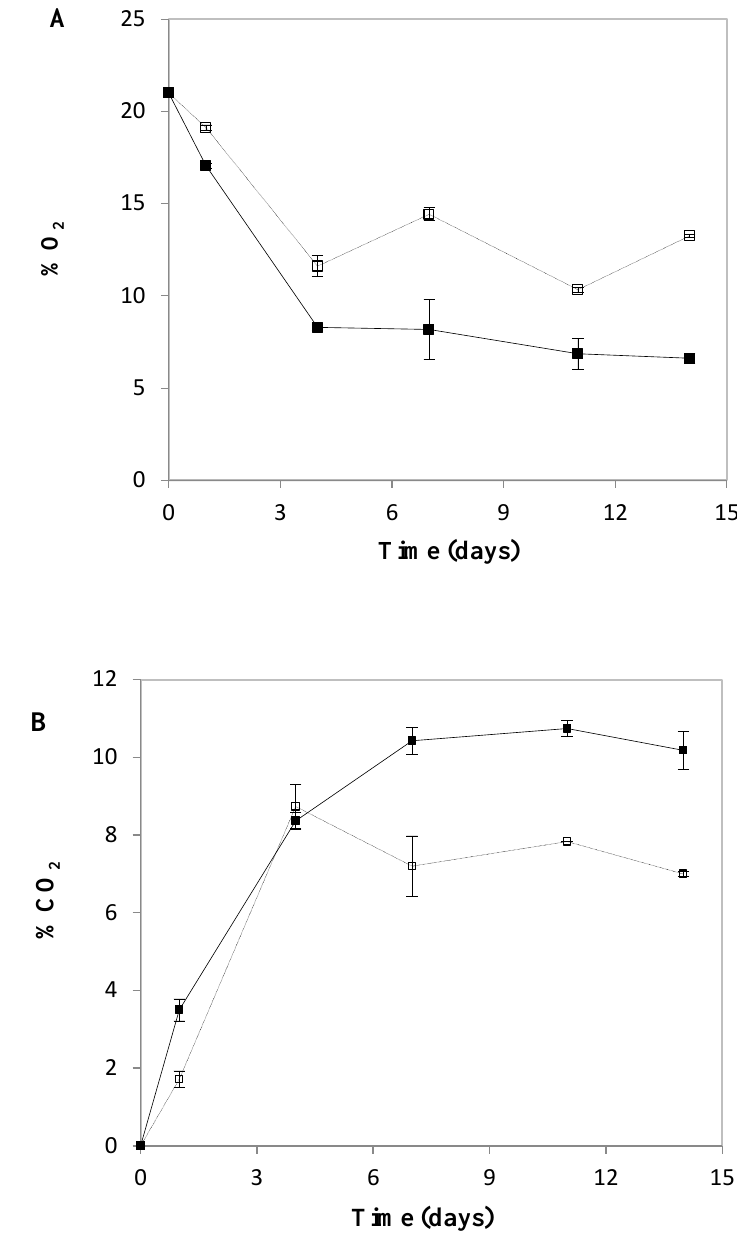
Figure 2. Headspace gas composition (O 2 %, ( A ); CO 2 %, ( B )) of minimally processed apples stored at 5 °C for 14 days for control sample ( ■ ) and coated sample ( ■ ).